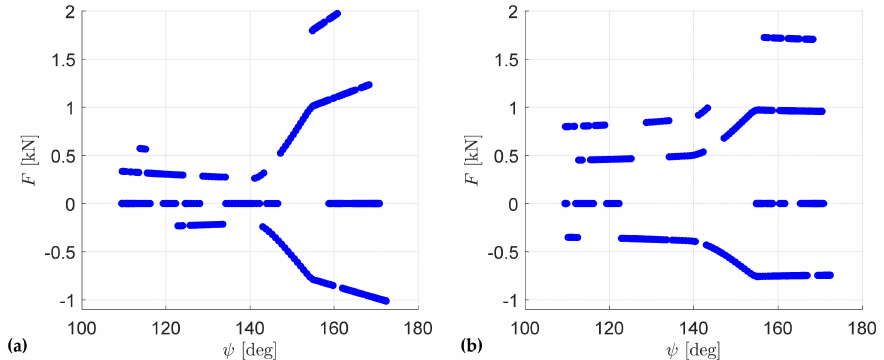
Figure 17. Forces (positive being outwards, negative being inwards) acting on the grooves of the guide plates: ( a ) grooves for mechanism 1; ( b ) grooves for mechanism